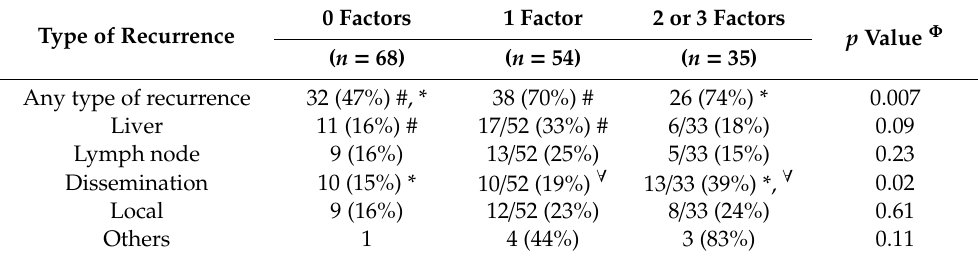
Table 4. Comparison of recurrence patterns among groups by number of preoperative predictable prognostic factors in patients with stage 3 / 4 gallbladder cancer without distant metastases. 0 Factors 1 Factor 2 or 3 Factors Type of Recurrence p Value Φ ( n = 68) ( n = 54) ( n = 35) Any type of recurrence 32 (47%) #, * 38 (70%) # 26 (74%) * 0.007 Liver 11 (16%) # 17 / 52 (33%) # 6 / 33 (18%) 0.09 Lymph node 9 (16%) 13 / 52 (25%) 5 / 33 (15%) 0.23 Dissemination 10 (15%) * 10 / 52 (19%) ∀ 13 / 33 (39%) *, ∀ 0.02 Local 9 (16%) 12 / 52 (23%) 8 / 33 (24%) 0.61 Others 1 4 (44%) 3 (83%)